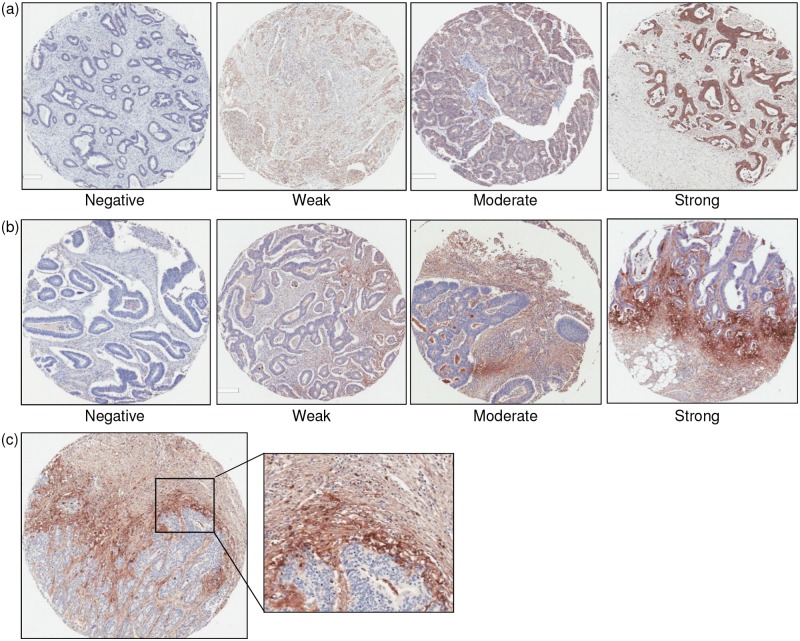
Staining intensities of uPARE (a; stained with anti-uPAR #3937 MAb) and uPARS (b; stained with anti-uPAR R4 MAb) were evaluated as negative, weak, moderate or strong.Peritumoral accentuation of uPAR (i.e., uPARPT; uPAR expression in stroma-associated cells and concentrated around the tumour epithelium) represented in (c), stained with R4.